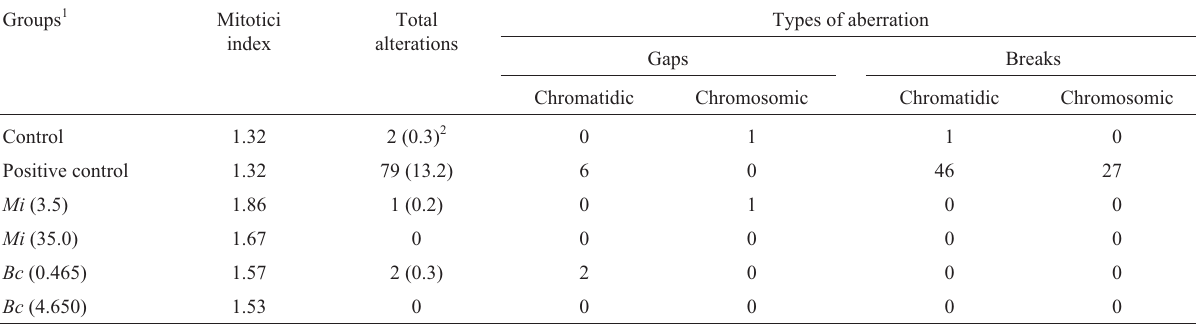
Table II - Mitotic index and chromosome aberrations of bone-marrow cells of Wistar rats treated with Maytenus ilicifolia ( Mi ) and Bauhinia candicans ( Bc ) infusions. Groups